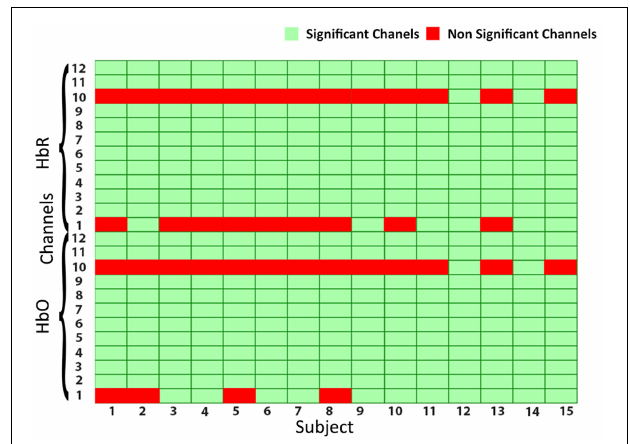
FIGURE 4 | The statistical significance of channels: green cells showing the significant channels, whereas red cells are non-significant channels.